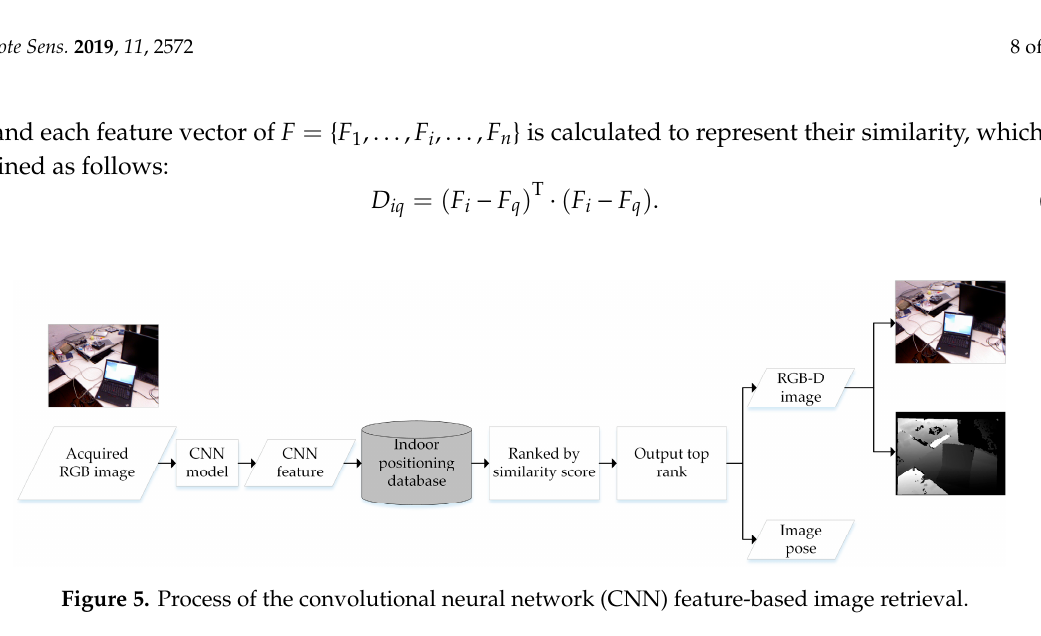
Figure 5. Process of the convolutional neural network (CNN) feature-based image retrieval.